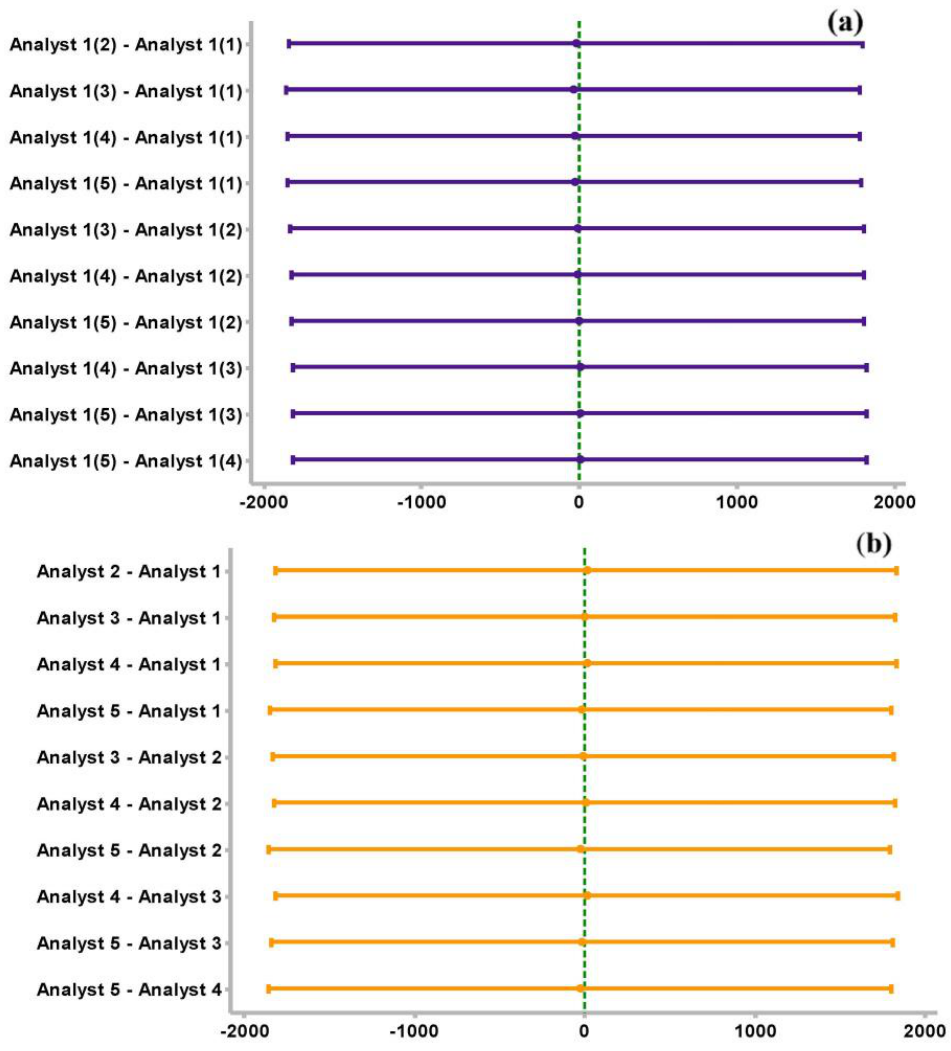
Figure 5. ( a ) Difference of means compared one to one for repeatability of the calibration curve. ( b ) Difference of means compared one to one for calibration reproducibility.